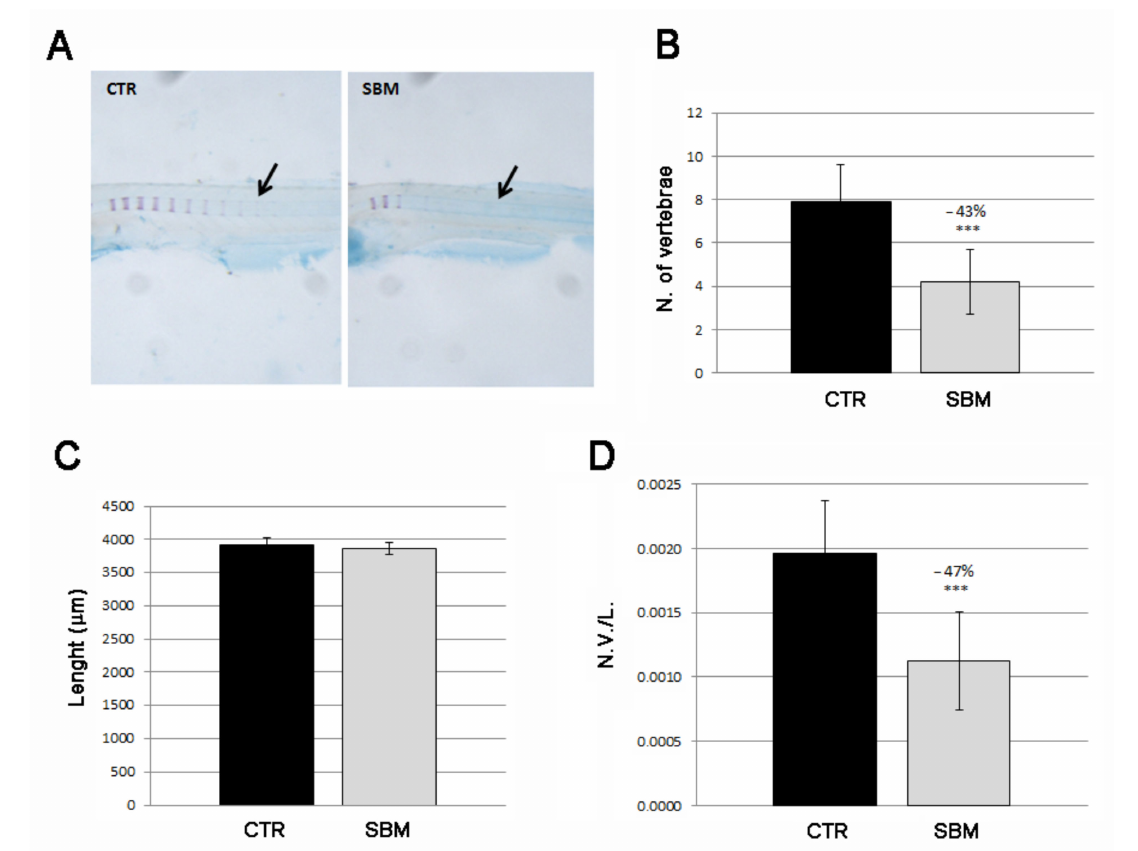
Figure 5. Lateral view of zebrafish larvae trunk double stained with alizarin red and alcian blue. ( A ) Mineralizing vertebrae of CTR and SBM embryos can be visualized in purple. Black arrow indicates a single vertebral body, which is formed by intramembranous mineralization. ( B ) Number of vertebrae in CTR and SBM larvae (SBM vs. CTR, − 43%, p < 0.001). ( C ) Larval length. ( D ) Number of vertebrae/total body length (N.V./L.) (SBM vs. CTR, − 47%, p < 0.001). Data derived from 10